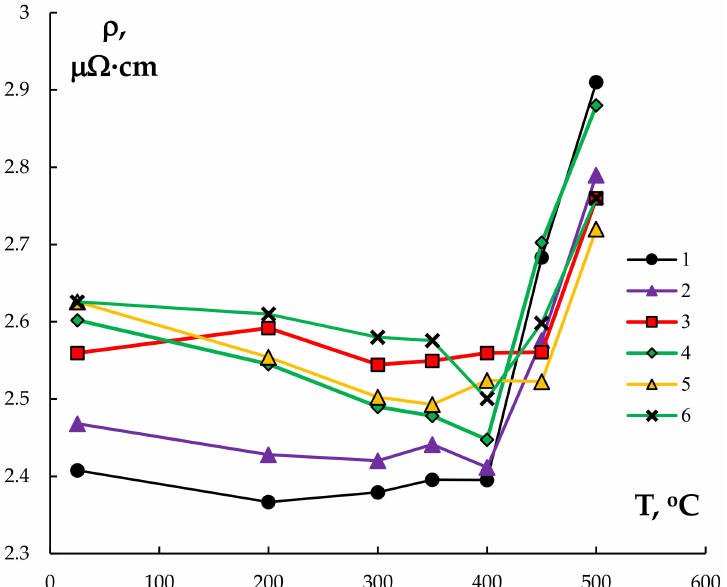
Figure 14. The dependencies of SER of the bimetallic wires on the 30 min annealing